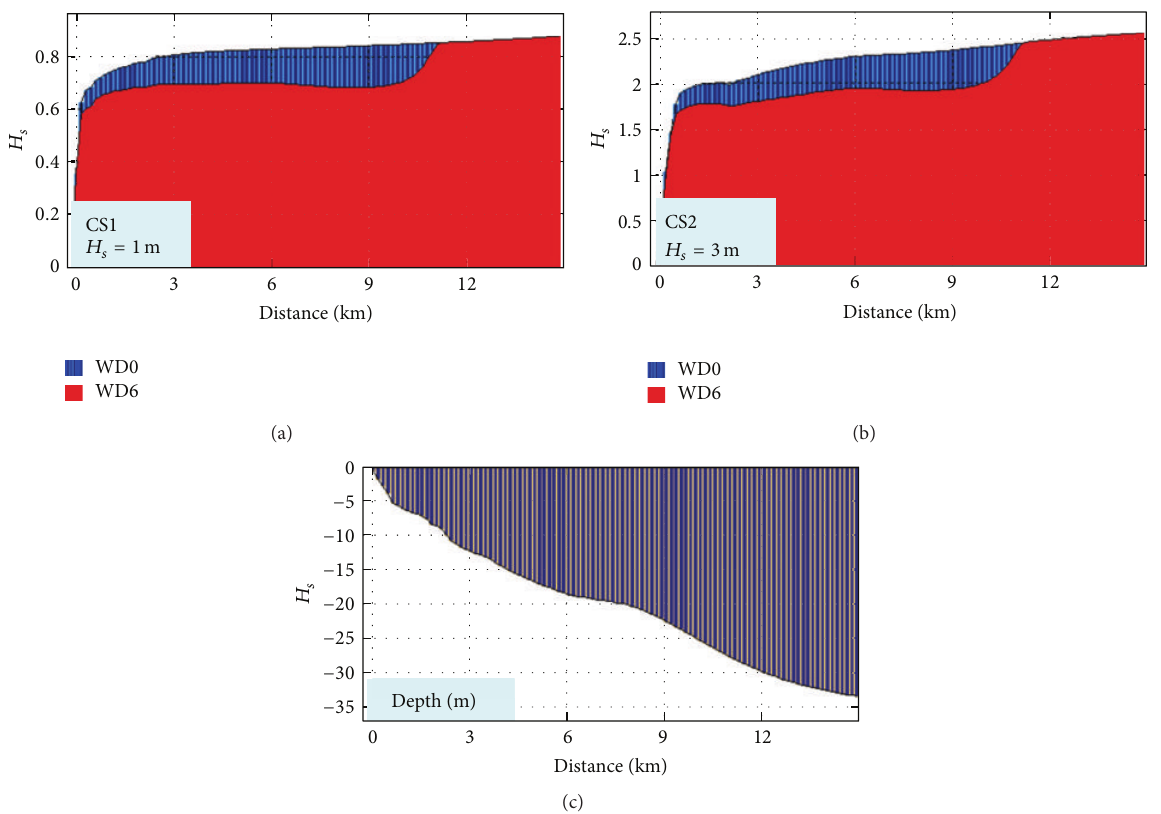
Figure 13: 𝐻 𝑠 variation along the reference line 2 without and with WD farm (WD0, WD6) for the two cases considered (CS1, CS2) and the variation of the water depth along the reference